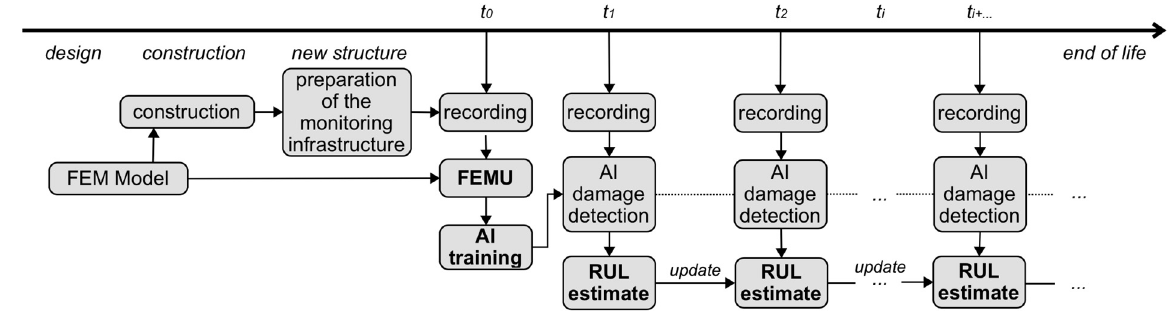
Figure 18. Development prospective for the calculation of RUL over the entire life cycle of the structure.